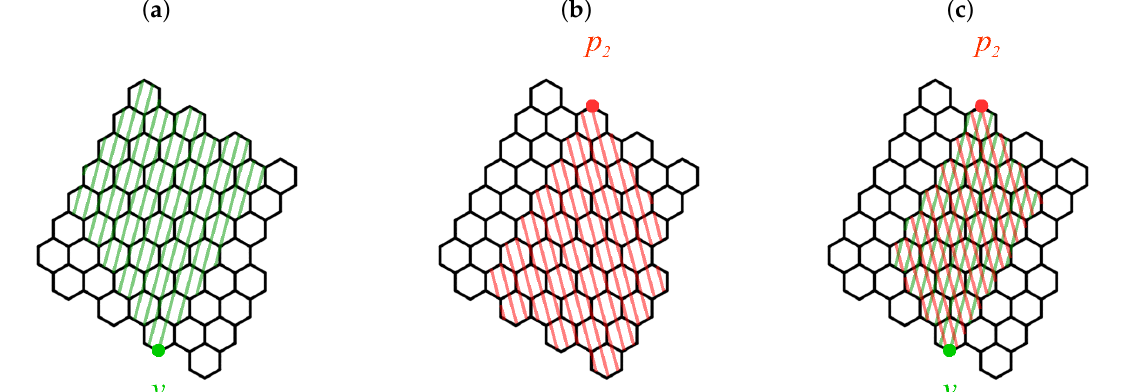
Figure 4. Schematic representations of various concepts related to John–Sachs theory: ( a ) funnel region of the valley v 3 , ( b ) wetting region of the peak p 2 , and ( c ) the p 2 → v 3 path region obtained as the intersection of the wetting region of p 2 and the funnel region of v 3